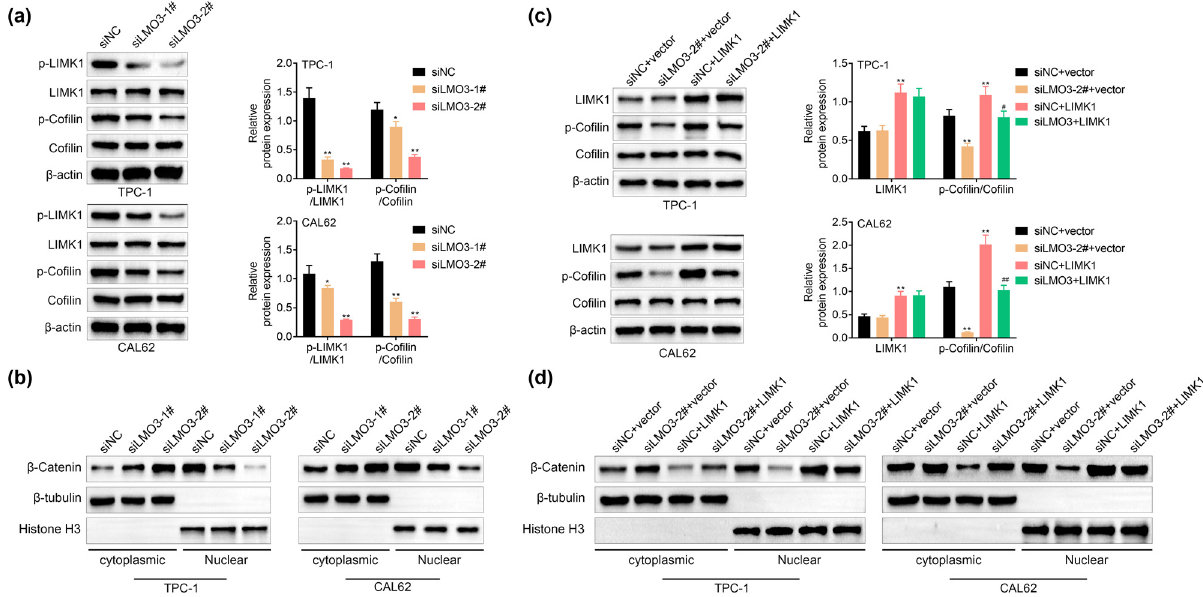
Figure 4: LMO3 contributed to LIMK1 - mediated activation of co fi lin and β - catenin pathways. ( a ) Knockdown of LMO3 decreased protein expression of co fi lin and LIMK1 phosphorylation, while it had no signi fi cant e ff ect on LIMK1 and co fi lin in TPC - 1 and CAL62. ( b ) Knockdown of LMO3 increased protein expression of cytoplasmic β - catenin and decreased nuclear translocation of β - catenin in TPC - 1 and CAL62. ( c ) Overexpression of LIMK1 promoted protein expression of co fi lin phosphorylation and attenuated LMO3 silence - induced decrease of co fi lin phosphorylation in TPC - 1 and CAL62. ( d ) Overexpression of LIMK1 attenuated LMO3 silence - induced upregulation of cytoplasmic β - catenin and downregulation of nuclear β - catenin in TPC - 1 and CAL62. ** vs siNC or siNC + vector, p < 0.01. #, ## vs siNC + LIMK1, p < 0.05, p <